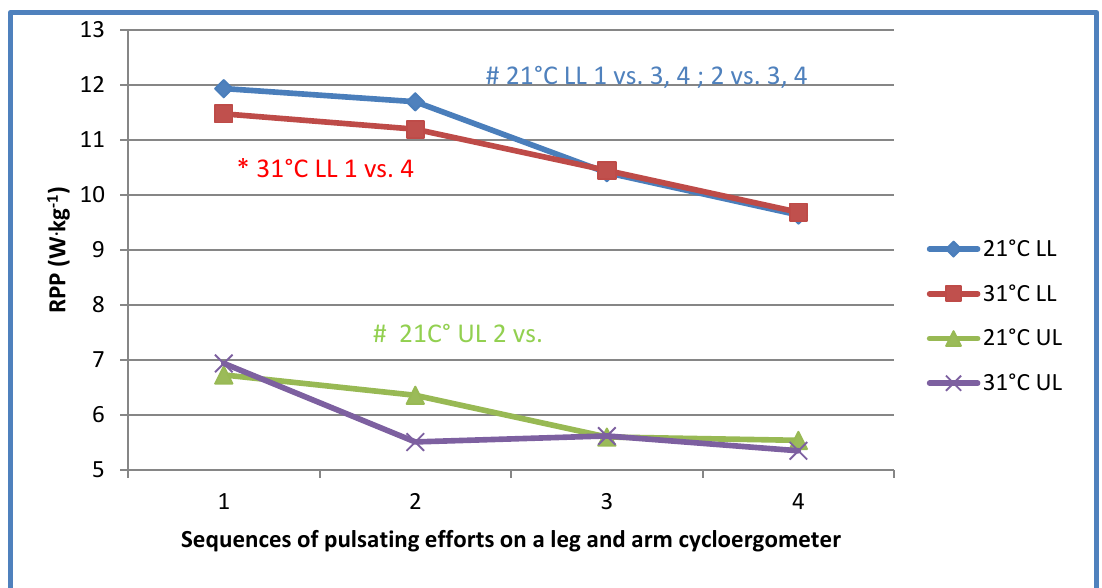
Figure 2. Relative peak power (RPP) values in the first of 5 series of physical exercises performed by the lower (LL) and upper limbs (UL) at ambient temperatures of 21 ◦ C and 31 ◦ C. #—significant differences at p < 0.05, 21 ◦ C: differences between individual measurements; *—significant differences at p < 0.05, 31 ◦ C: differences between individual